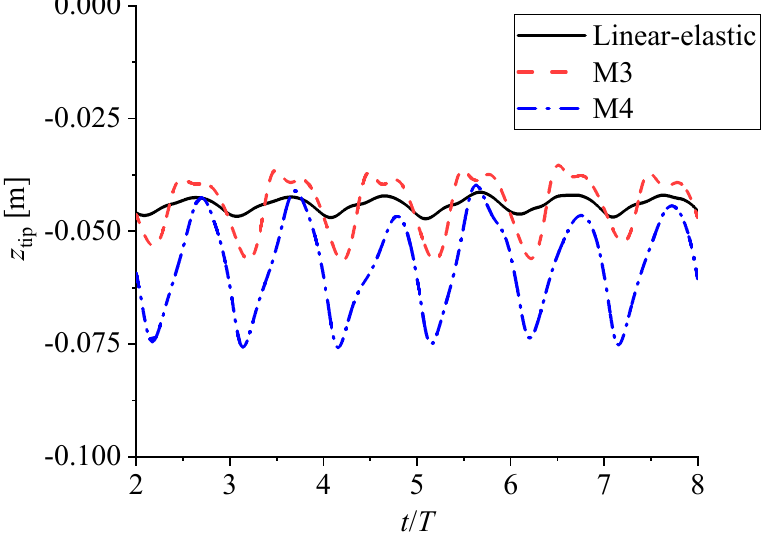
Figure 15. Tip displacement of the membrane with different materials ( H = 0.1 m, T = 0.8 s, and d = 0.18 m).